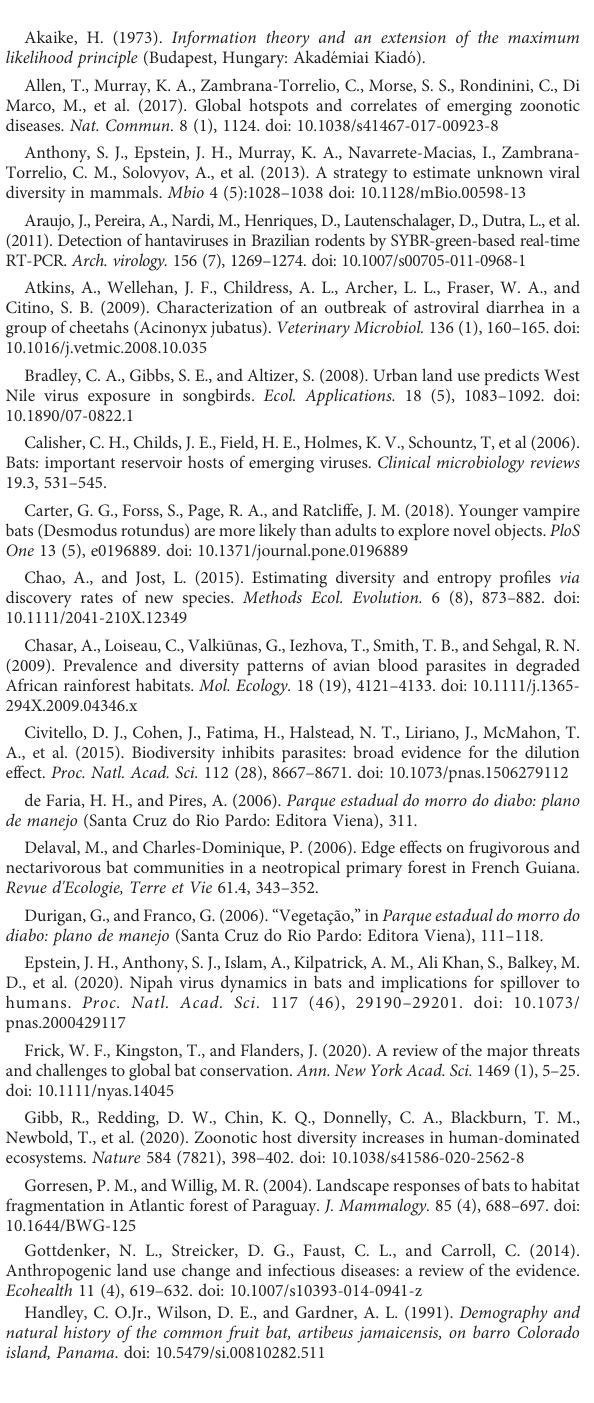
SUPPLEMENTARY FIGURE 4 Herpesvirus Maximum Likelihood Phylogenetic Tree. Genetic analysis of 189 nucleotide partial Polymerase (pol) gene. Tree reconstructed by MEGA7 with heuristic search, Neighbor-Joining “ NJ ” algorithm and Model GTR+gamma+I. The principal node values superior to 70% represent 1,000 bootstrap replicates.